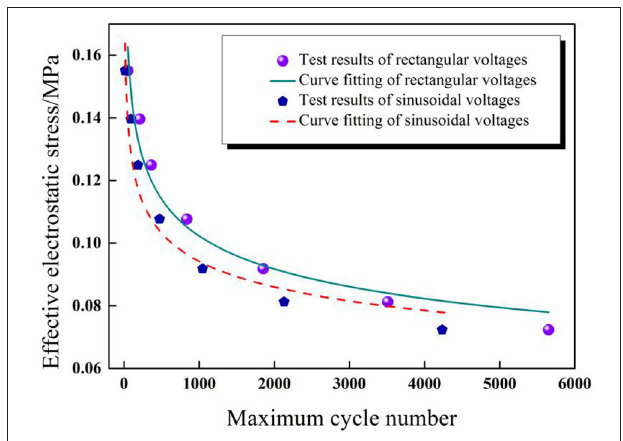
FIGURE 11 | Comparison diagram of the fitting results and experimental results of maximum cycle numbers under sinusoidal and rectangular voltage excitation.